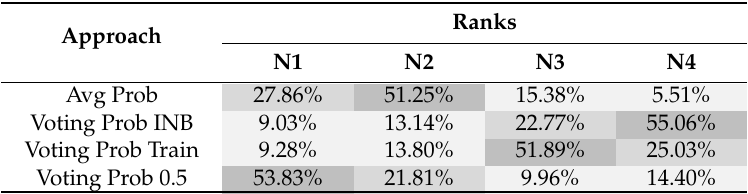
Table 5. Distribution of global ranks for probability assignment in terms of the AUC measure observed for the validation